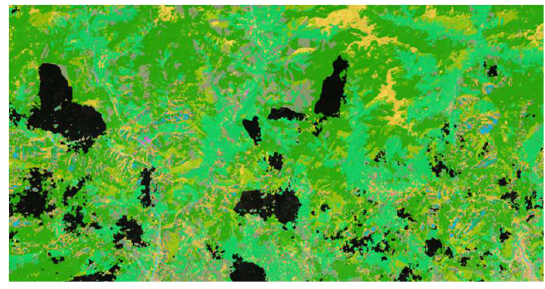
Fig. 11. Region scale (PACA) land cover As regards the detection change, the ONERA REACTIV Tool (Rapid and Easy Change Detection in RADAR Time- series by Variation coefficient) was integrated on the AI4GEO platform. As detailed in [10], changes are highlighted in SAR time series by analyzing the Variation coefficient. It provides change visualization capability by colorizing pixels depending on change detection date.